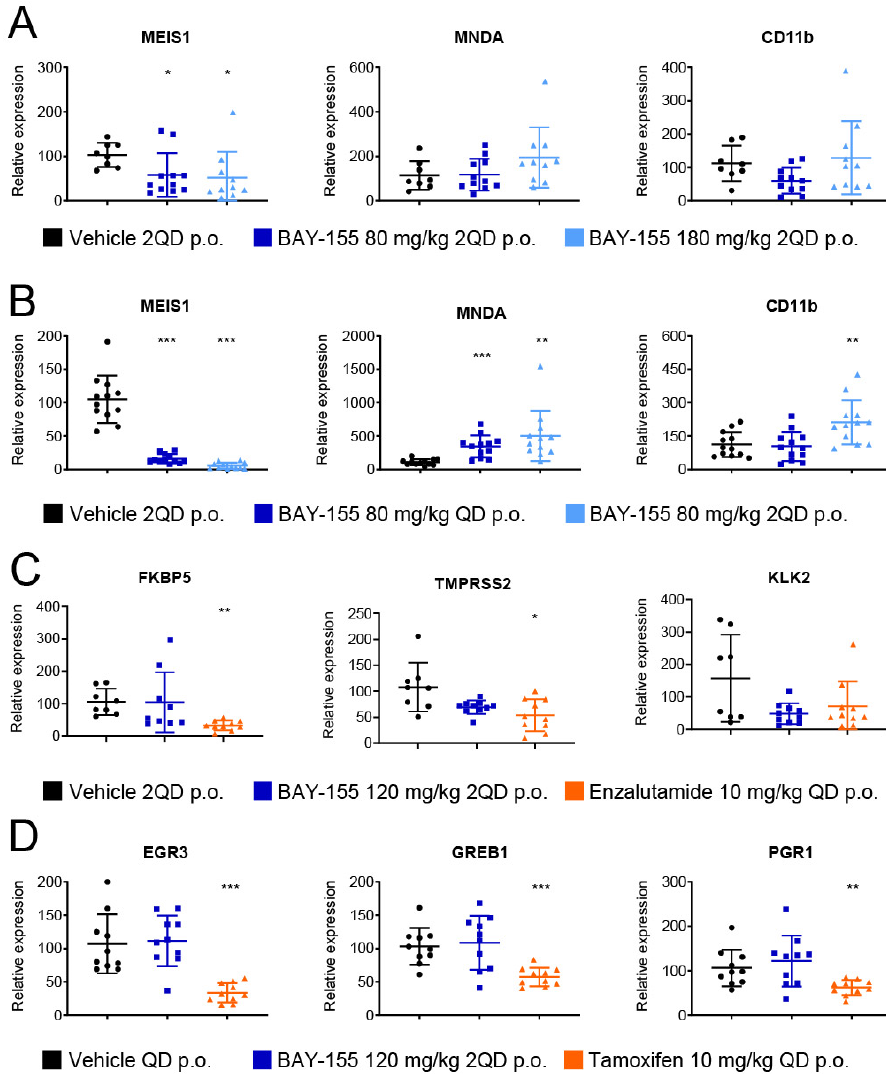
Figure 6. Mechanistic mode of action e ff ects of BAY-155 ex vivo. ( A , B ) Relative expression level of MEIS1 , MNDA and CD11b after 17 or 11 days of treatment with BAY-155 or vehicle at the indicated dose in MV4;11 ( A ) or MOLM-13 ( B ) xenografts, respectively. ( C ) Relative expression level of FKBP5 , TMPRSS2 and KLK2 after 52 days of treatment with BAY-155, enzalutamide or vehicle at the indicated dose in VCaP xenografts. ( D ) Relative expression level of EGR3 , GREB1 and PGR1 after 27 days of treatment with BAY-155, tamoxifen or vehicle at the indicated dose in MCF7 xenografts. Data were normalized to 18S RNA and the average vehicle control. Significant di ff erence between vehicle control and treatment group: * p -value ≤ 0.05, ** p -value ≤ 0.01, *** p -value ≤ 0.001, two-sided t -test.